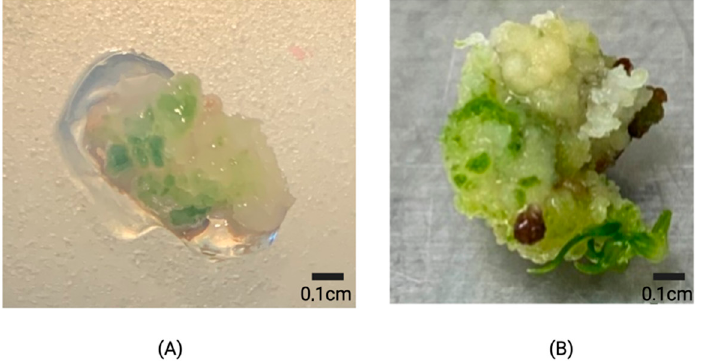
Figure 5. Regeneration in MS medium with 0.5 mg L − 1 of NAA + 3 mg L − 1 BA of an induced calli with 2 mg L − 1 of 2,4-D after 15 days of induction. Regeneration in ( A ) semisolid medium and ( B )